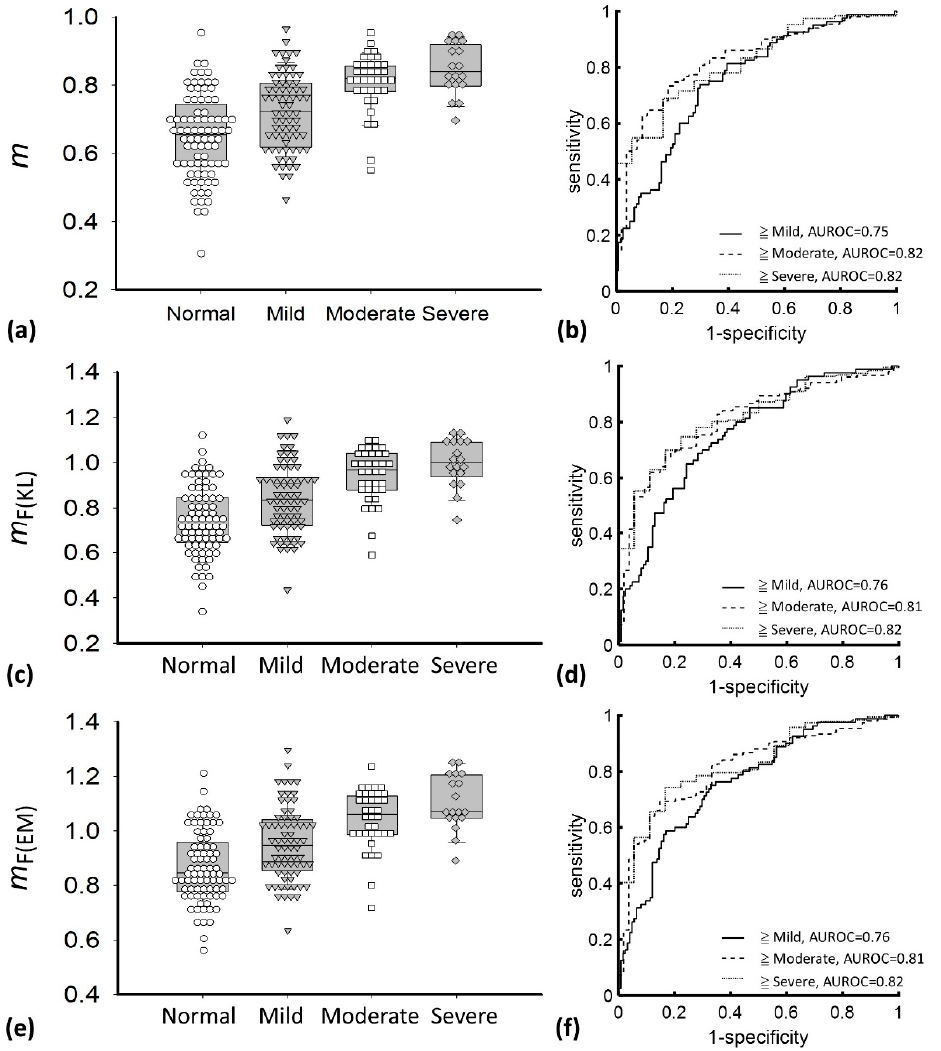
Figure 9. Parameters m , m F(KL) , and m F(EM) as a function of hepatic steatosis grade ( a – c ) and the ROC curves for diagnosing hepatic steatosis ( d – f ). Ultrasound DND imaging was able to detect hepatic steatosis with the same performance as the conventional Nakagami imaging.